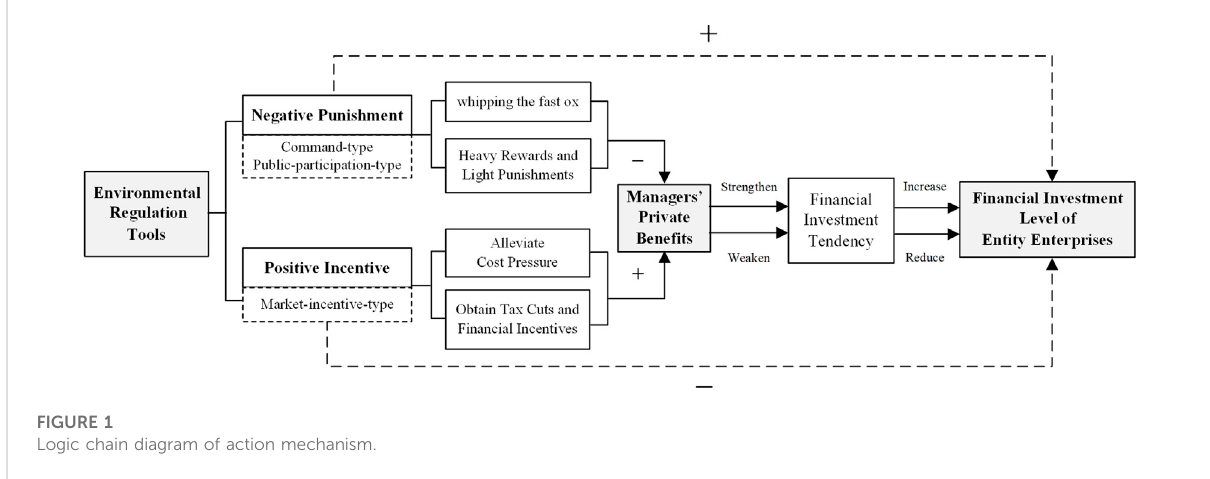
FIGURE 1 Logic chain diagram of action